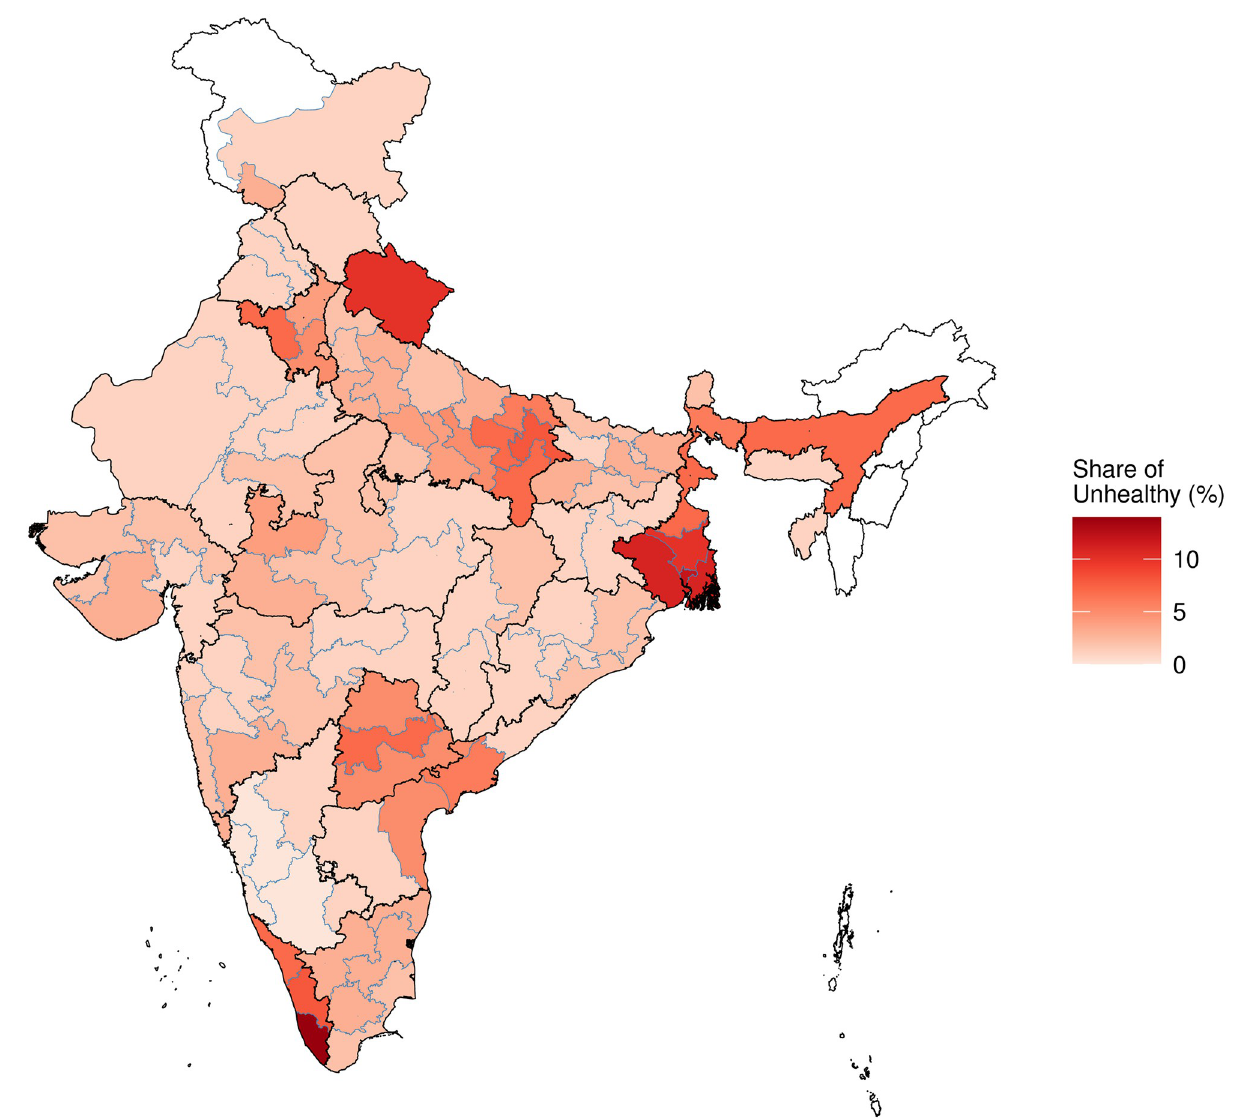
Fig 1. Share of unhealthy people across